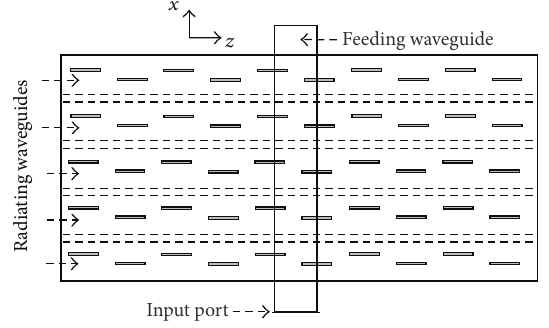
Figure 1: Geometry of an array or